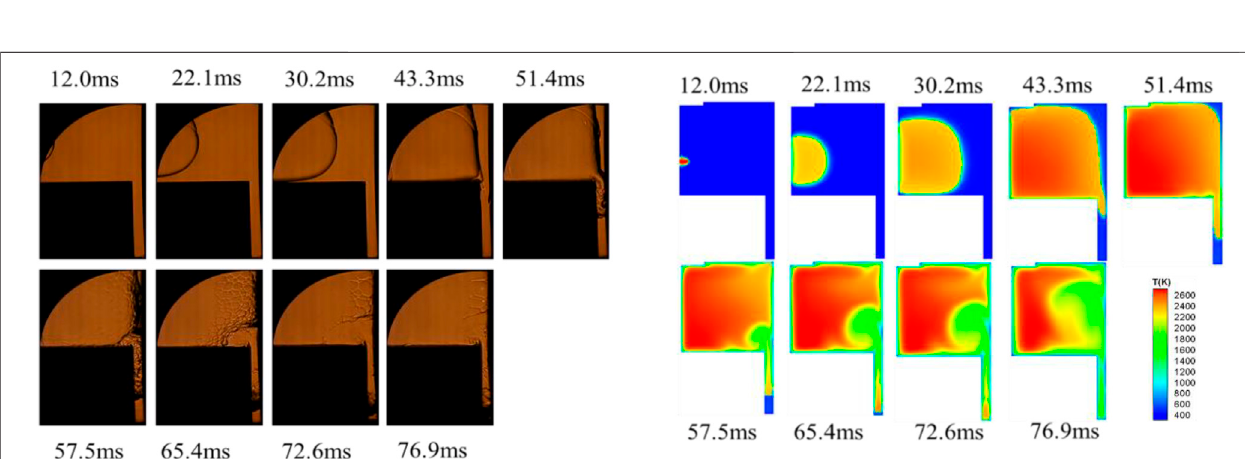
Frontiers in Mechanical Engineering |